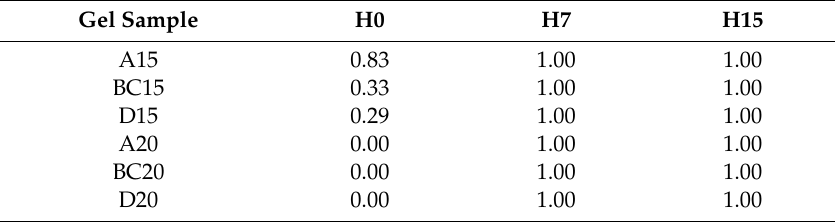
Table 4. Ratio of food gel-fracture on artificial tongue.